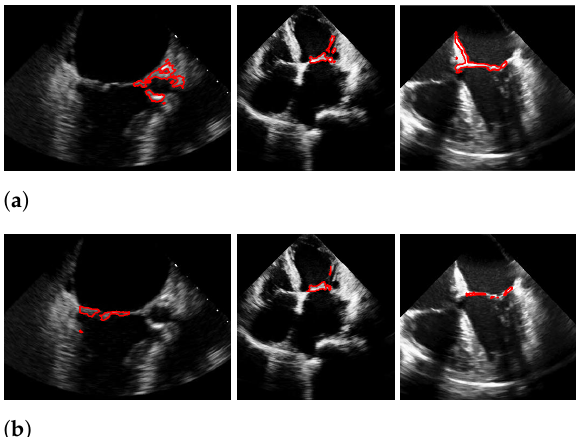
Figure 19. Types of segmentation failures. ( a ) segmentation of Corinzia et al. ; ( b ) segmentation with